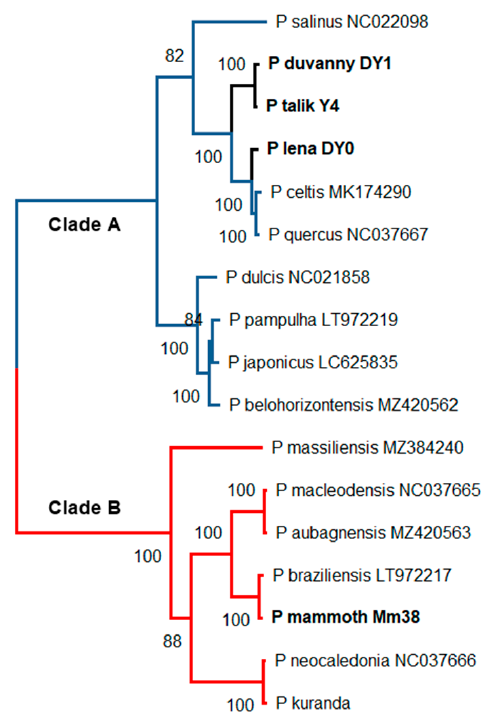
Figure 2. Maximum-likelihood phylogenetic relationships of the available Pandoravirus isolates. The tree (rooted at midpoint) was built using IQ-TREE (version 1.6.2) [54] from 2067 gap-free sites in the multiple alignment of 17 RNA polymerases (RPB1) protein (best fit model: “JTT + F + I + G4”). The permafrost isolates (in bold) are distributed between the two separate Pandoraviridae clades previously documented [55]. Accession numbers are indicated following the isolate name when